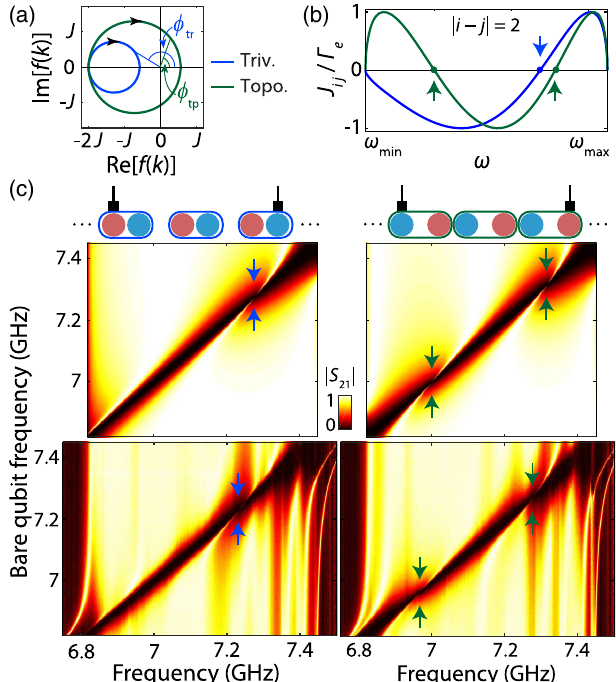
FIG. 3. Probing band topology with qubits. (a) f ð k Þ in the complex plane for k values in the first Brillouin zone. ϕ ( ϕ ) is tr tp the phase angle of f ð k Þ for a trivial (topological) section of waveguide, which changes by 0 ( π ) rad as kd transitions from 0 to π (arc in upper plane following black arrowheads). (b) Coherent exchange interaction J between a pair of coupled qubits as a ij function of frequency inside the passband, normalized to indi- vidual qubit decay rate Γ [only kd ∈ ½ 0 ; π Þ branch is plotted]. e Here, one qubit is coupled to the A sublattice of the i th unit cell and the other qubit is coupled to the B sublattice of the j th unit cell, where j i − j j ¼ 2 . Blue (green) curve corresponds to a trivial (topological) intermediate section of waveguide between qubits. 0 (filled circles with arrows) correspond to The intercepts at J ij ¼ points where perfect superradiance occurs. (c) Waveguide trans- mission spectrum j S 21 j as a qubit pair are resonantly tuned across the UPB of device I [left, ( Q A 2 ; Q B 4 ); right, ( Q B 2 ; Q A 5 )]. Top: schematic illustrating system configuration during the experi- ment, with left (right) system corresponding to an interacting qubit pair subtending a three-unit-cell section of waveguide in the trivial (topological) phase. Middle and bottom: two-dimensional color intensity plots of j S 21 j from theory and experiment, respectively. Swirl patterns (highlighted by arrows) are observed in the vicinity of perfectly superradiant points, whose number of occurrences differs by one between trivial and topological waveguide